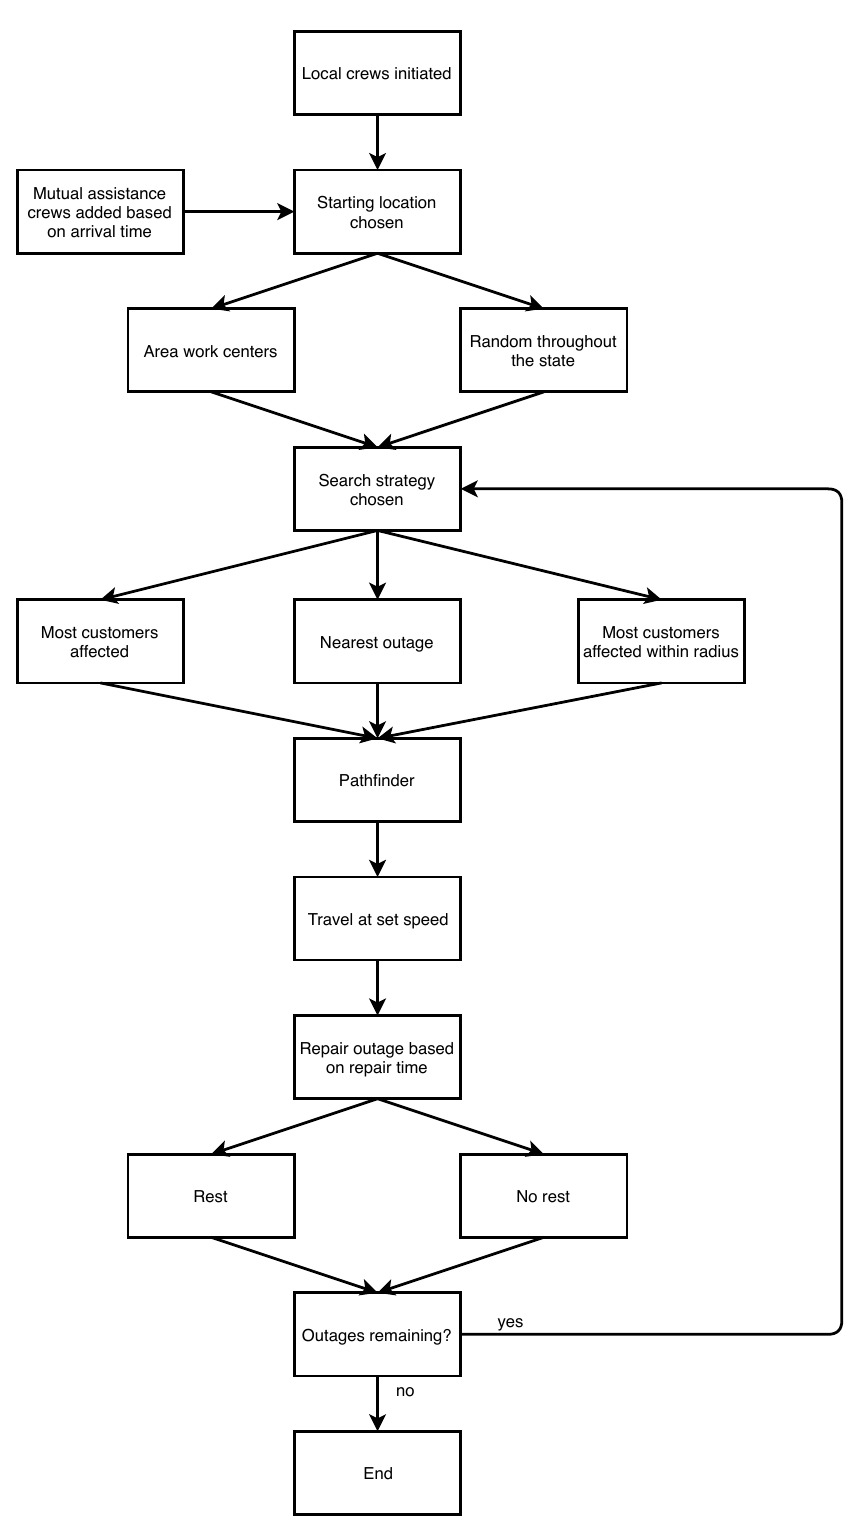
Figure 1. Flowchart of model decision